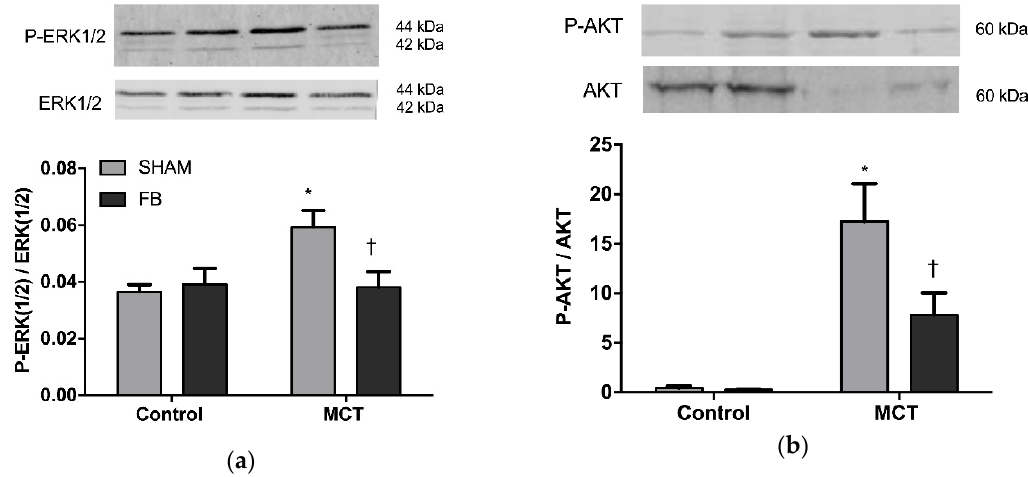
Figure 4. Xanthohumol-fortified beer (FB) effect on pulmonary expression of p-ERK1/2/ERK1/2 ratio ( a ) and p-AKT/AKT ratio ( b ) of healthy (control) or monocrotaline (MCT)-induced PAH animals. Data are mean ± SEM from 8 animals per group. * p < 0.05 vs. respective control group, † p < 0.05 vs. MCT + SHAM.